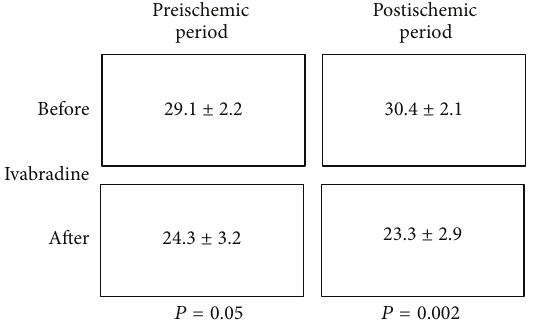
Figure 1: Pre and after ischemic period, before and after 6 months of follow-up of oral